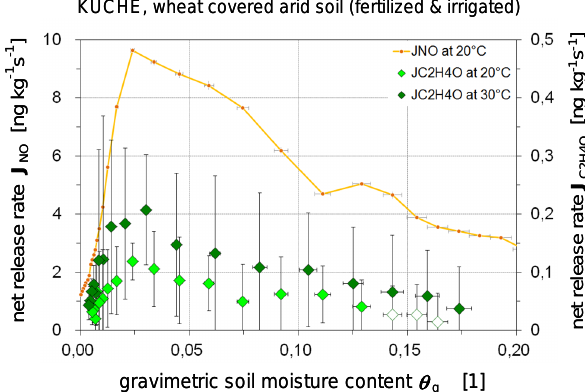
Figure 15. Net NO release rate ( T soil = 20 ◦ C) and net acetalde- hyde (C 3 H 6 O) release rates ( T soil = 20 ◦ C and 30 ◦ C) at fumiga- Fig. 15: Net NO release rate ( T soil =20°C) and net acetaldehyde (C 3 H 6 O) release rates tion with zero air of a sample taken from an arid, but agricultur- ( T soil = 20°C and 30°C) at fumigation with “zero”-air of a sample taken from an ally managed (fertilised and irrigated) corn covered soil in southern arid, but agriculturally managed (fertilized & irrigated) corn covered soil in Xinjiang, P. R. China. Data points marked by empty diamonds fall southern Xinjiang, P.R. China. Data points marked by empty diamonds fall within the “deadband” of non-detectable values. Note that net NO within the “deadband” of non-detectable values. Note, that net NO release rates release rates are expressed in terms of mass of nitrogen (N), while are expressed in terms of mass of nitrogen (N), while those of C 3 H 6 O in terms of mass of carbon (C). those of C 3 H 6 O in terms of mass of carbon (C).